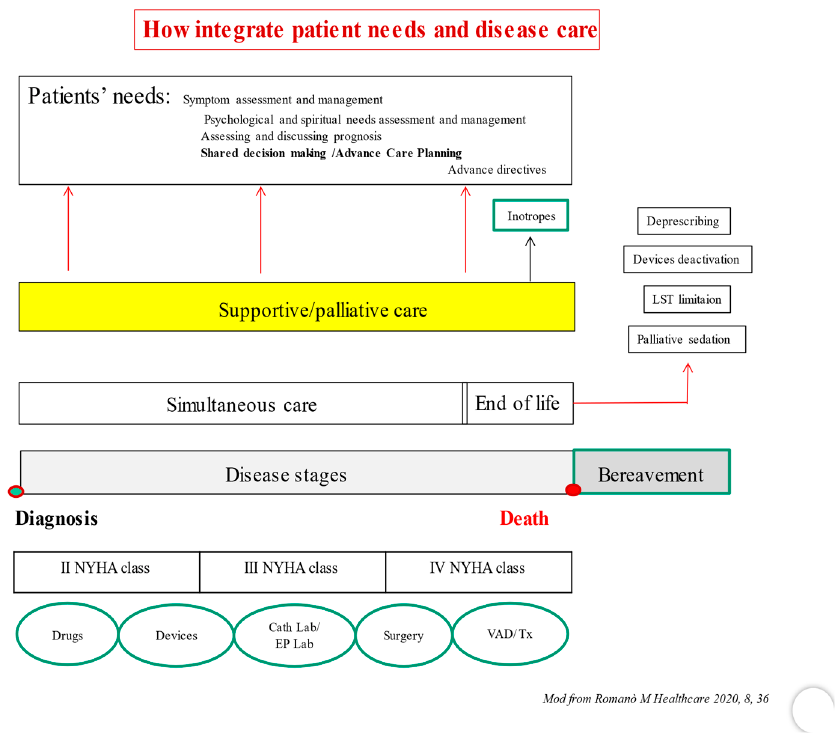
Figure 3. See text for details. VAD: Ventricular Assist Device, Tx . Cardiac transplant . EP Lab: Electrophysiologic Laboratory, Cath lab: Catheterization Laboratory, LST: Life Support Treatments.